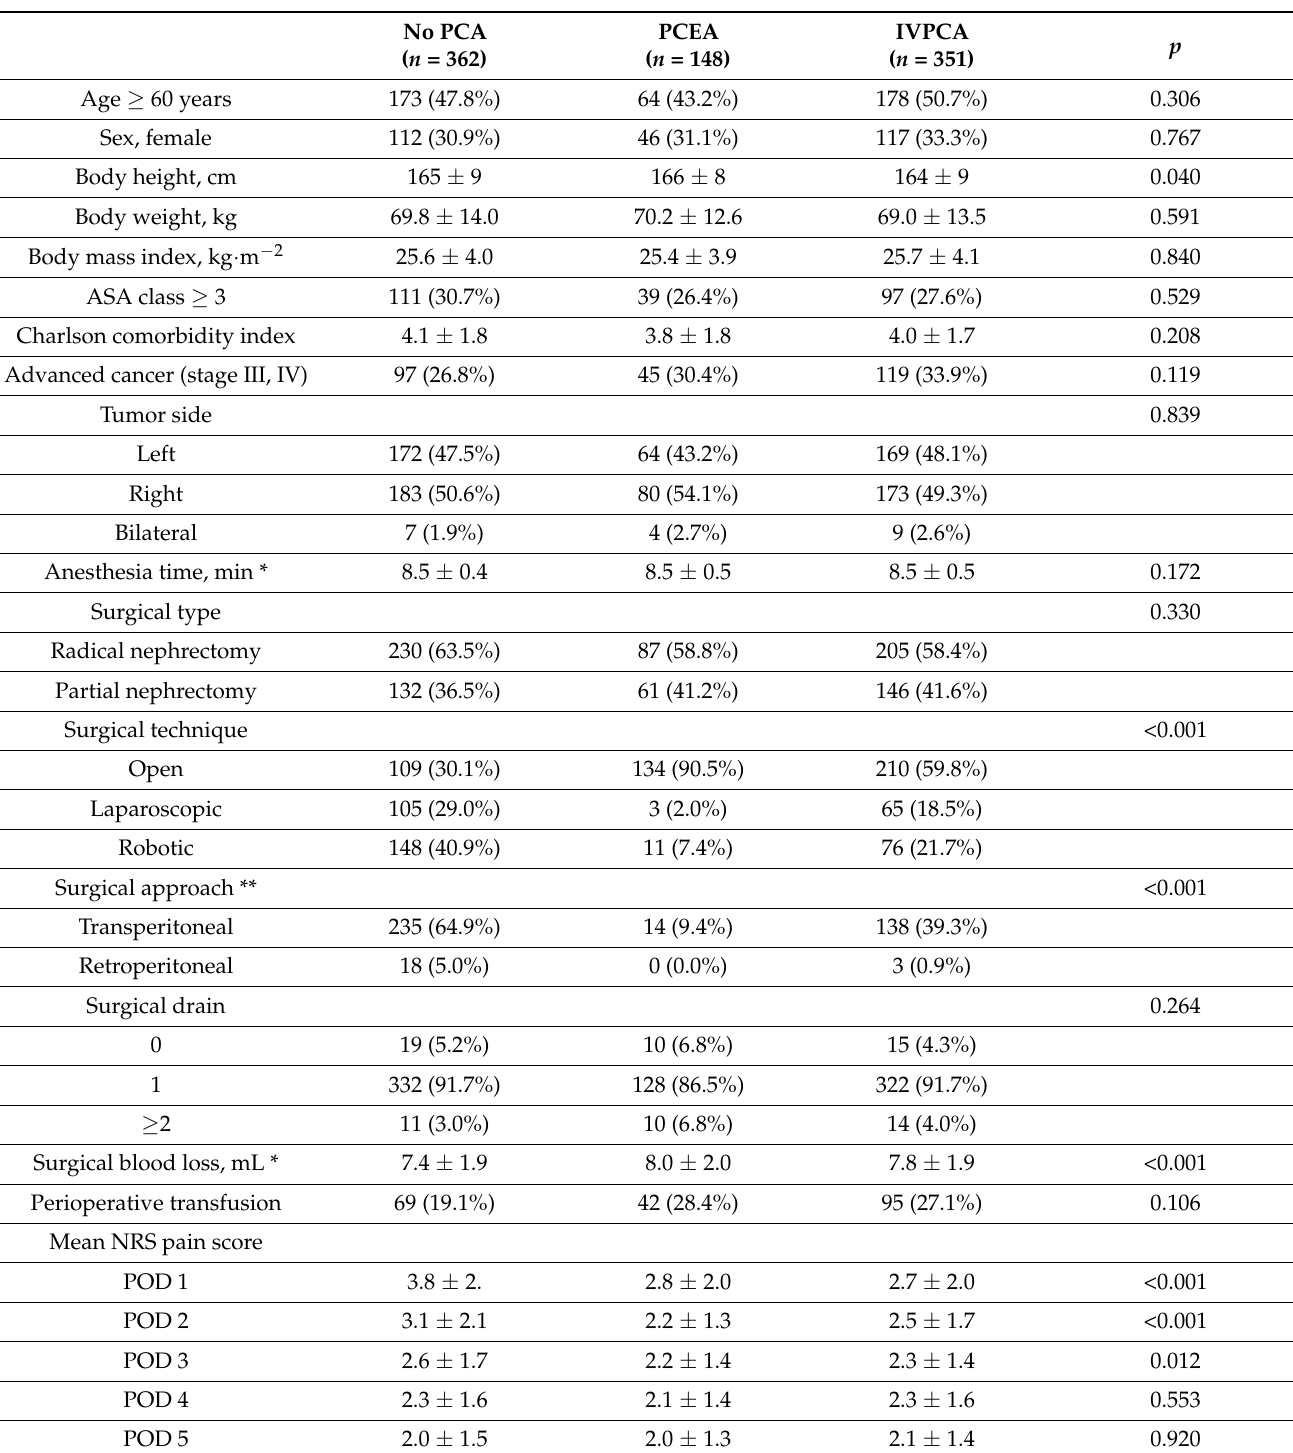
Table 1. Comparisons of patient characteristics and postoperative pain among the PCEA, IVPCA, and no PCA